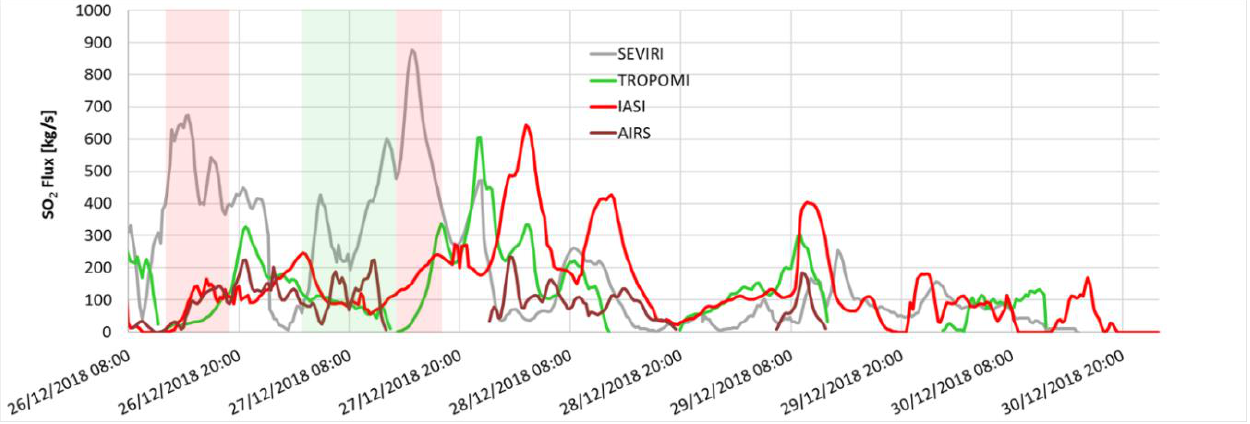
Figure 10. Cross-comparison between the SO 2 fluxes obtained from SEVIRI, TROPOMI, IASI and AIRS measurements. The colored rectangle areas indicate the regions where the GEO and LEO retrieval discrepancies are significant. Light red areas: differences due to LEO images not available and/or where the plume dilution of the distal part of the cloud is significant. Light green area: differences due to the presence of volcanic ash.